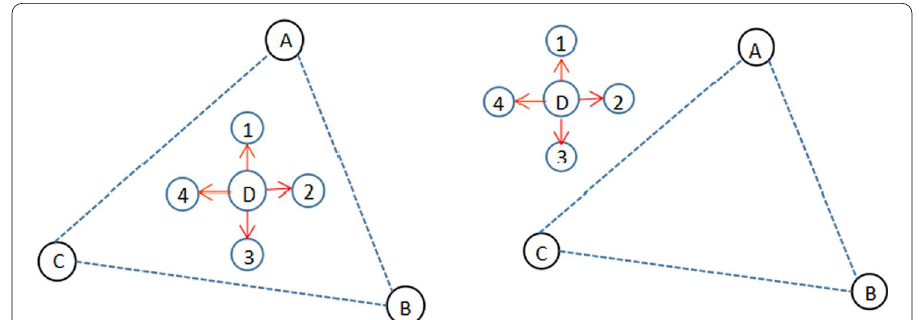
Fig. 3 The schematic diagram of the PIT criterion. This figure shows how to judge whether the node is located within the